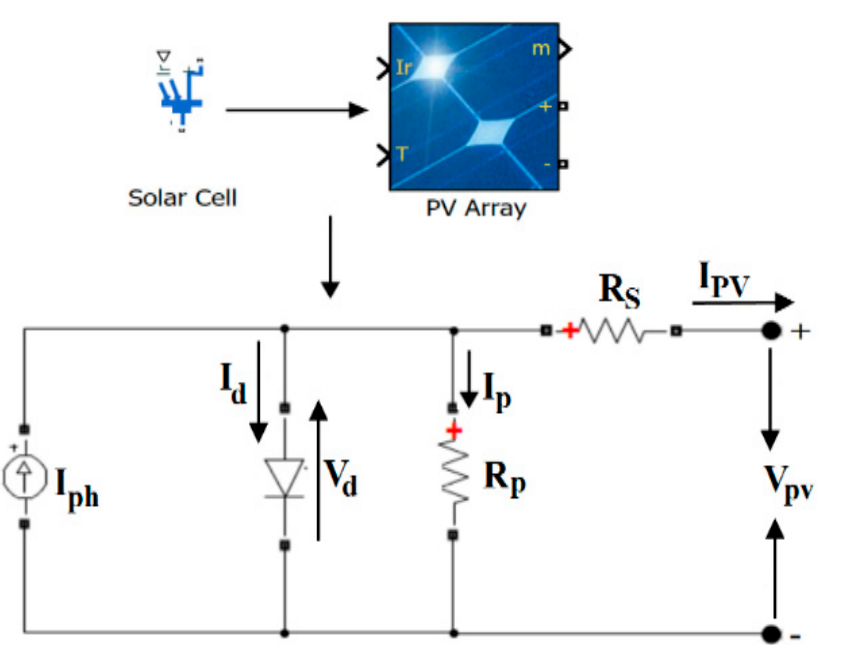
Figure 6. Solar cell, array and equivalent circuit. Irrespective of the electrical analysis, the solar panels are modelled as a constant current source. Two or more solar cells connected together in series/parallel and arranged in a frame form a solar panel or module, while groups of solar panels make a solar array. Considering the equivalent solar cell diagram in Figure 6, the solar cell current is represented by ( I PV ) , solar cell voltage ( V PV ) , the photo current ( I ph ) , a series resistor ( R s ) and shunt resistor ( R p ) . The current across the diode ( I d ) , shunt resistor and ( V d ) is for diode voltage. The solar current expression can be obtained in Equation (4). From Equation (5), ( q ) is the quantity of electron charge ( 1.6 × 10 − 19 C), ( A ) is the ideality factor of the diode, ( K ) is the Boltzmann’s constant the operating temperature and ( I S ) is the diode saturation current, or dark current. The increase in the irradiation of the solar system will result in the increase in the solar voltage and power. The temperature increase can, consequently, have a negative impact on the output voltage and power